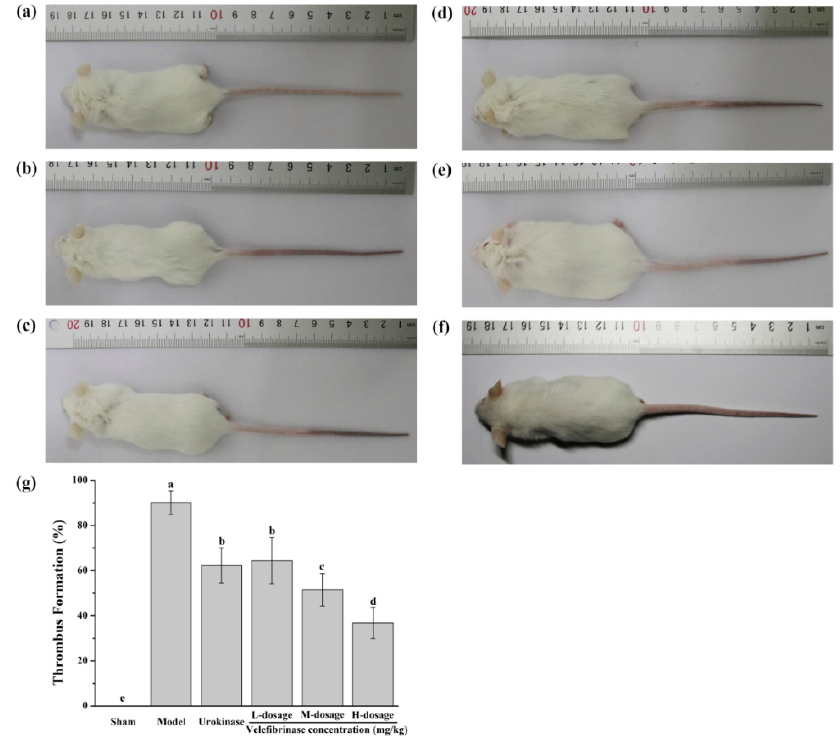
Figure 7. Velefibrinase ameliorated the length of the mouse tail thrombus induced by κ -carrageenan ( n = 6 per group). The mice were injected intravenously ( a ) isotonic saline only (sham), ( b ) 40 mg/kg κ -carrageenan (model), ( c ) 40 mg/kg κ -carrageenan + 0.44 mg/kg urokinase, ( d ) 40 mg/kg κ -carrageenan + 0.22 mg/kg Velefibrinase (low-dosage), ( e ) 40 mg/kg κ -carrageenan + 0.44 mg/kg Velefibrinase (middle-dosage), and ( f ) 40 mg/kg κ -carrageenan + 0.88 mg/kg Velefibri- nase (high-dosage). ( g ) The length of the mouse tail infarcted region of different treatment groups. Each value is expressed as a mean ± standard deviations (SDs). Different letters indicate significant differences ( p < 0.05) in each group.